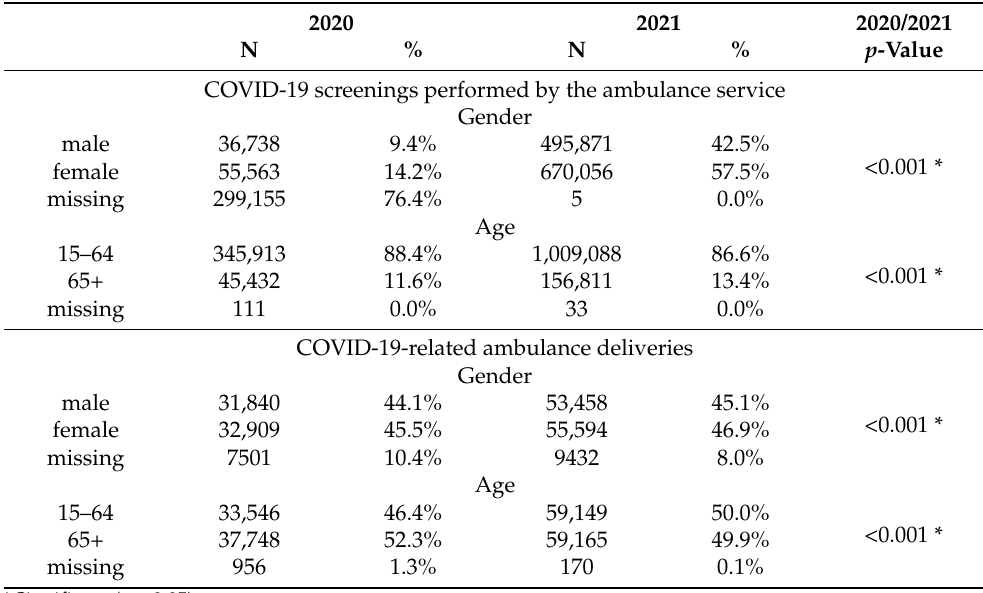
Table 2. Number and distribution of COVID-19 screenings and COVID-19-related deliveries by